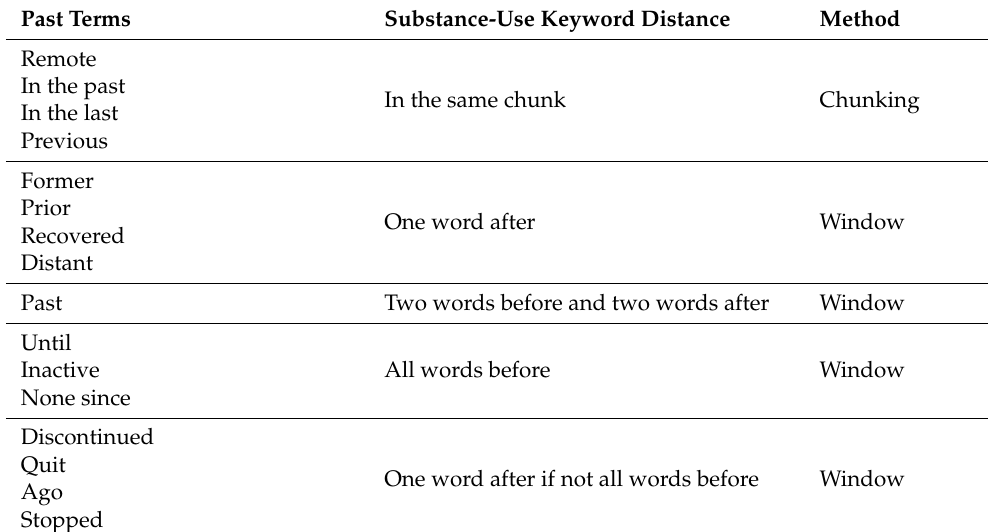
Table 5. Past temporal status terms and search